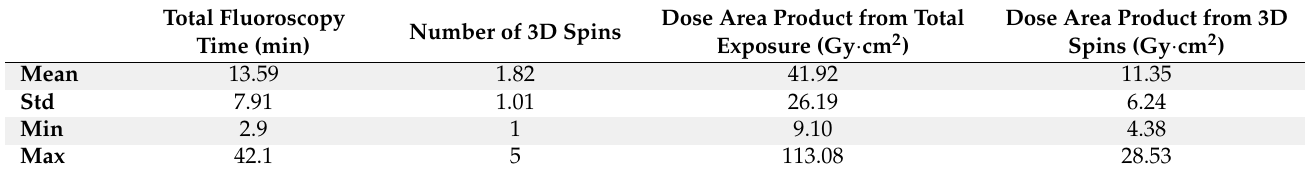
Table 4. Fluoroscopy and Cone-Beam CT-Associated Radiation